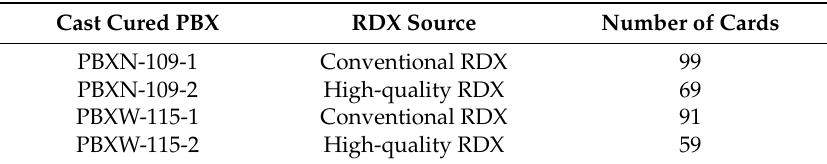
Table 8. The shock sensitivity of RDX-based cast-cured PBXs. Cast Cured PBX RDX